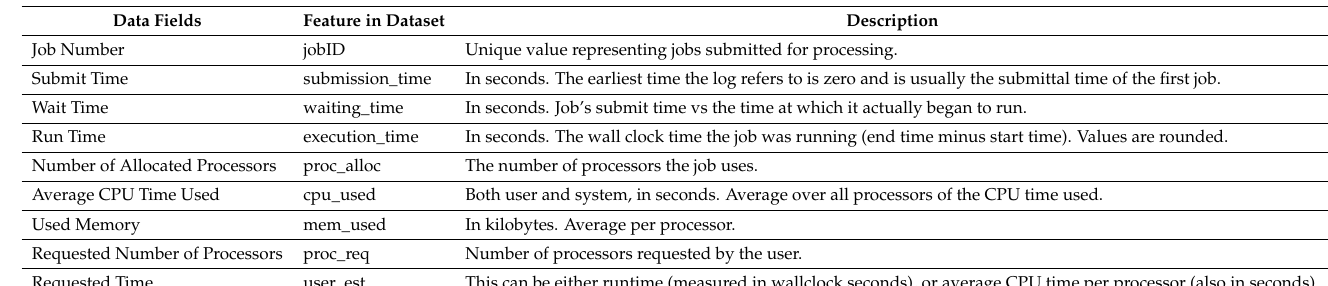
Table 5. Data fields of the Parallel Workload logs chosen for